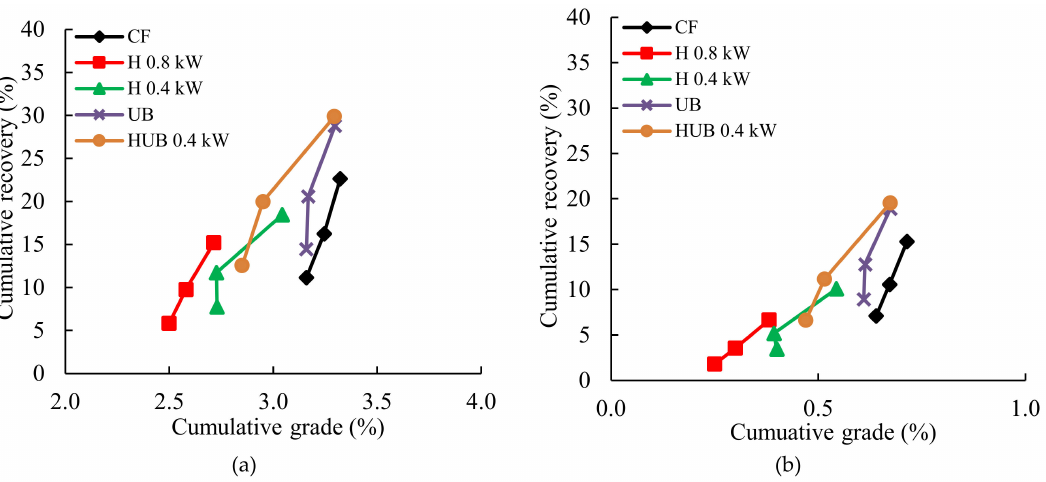
Figure 6. Grade and recovery curves for ( a ) SiO 2 and ( b ) Al 2 O 3 at the re-cleaner